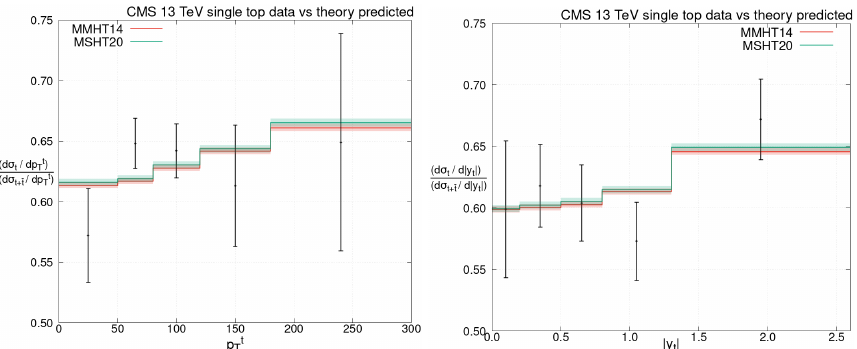
(left) and y (right) distributions compared T t